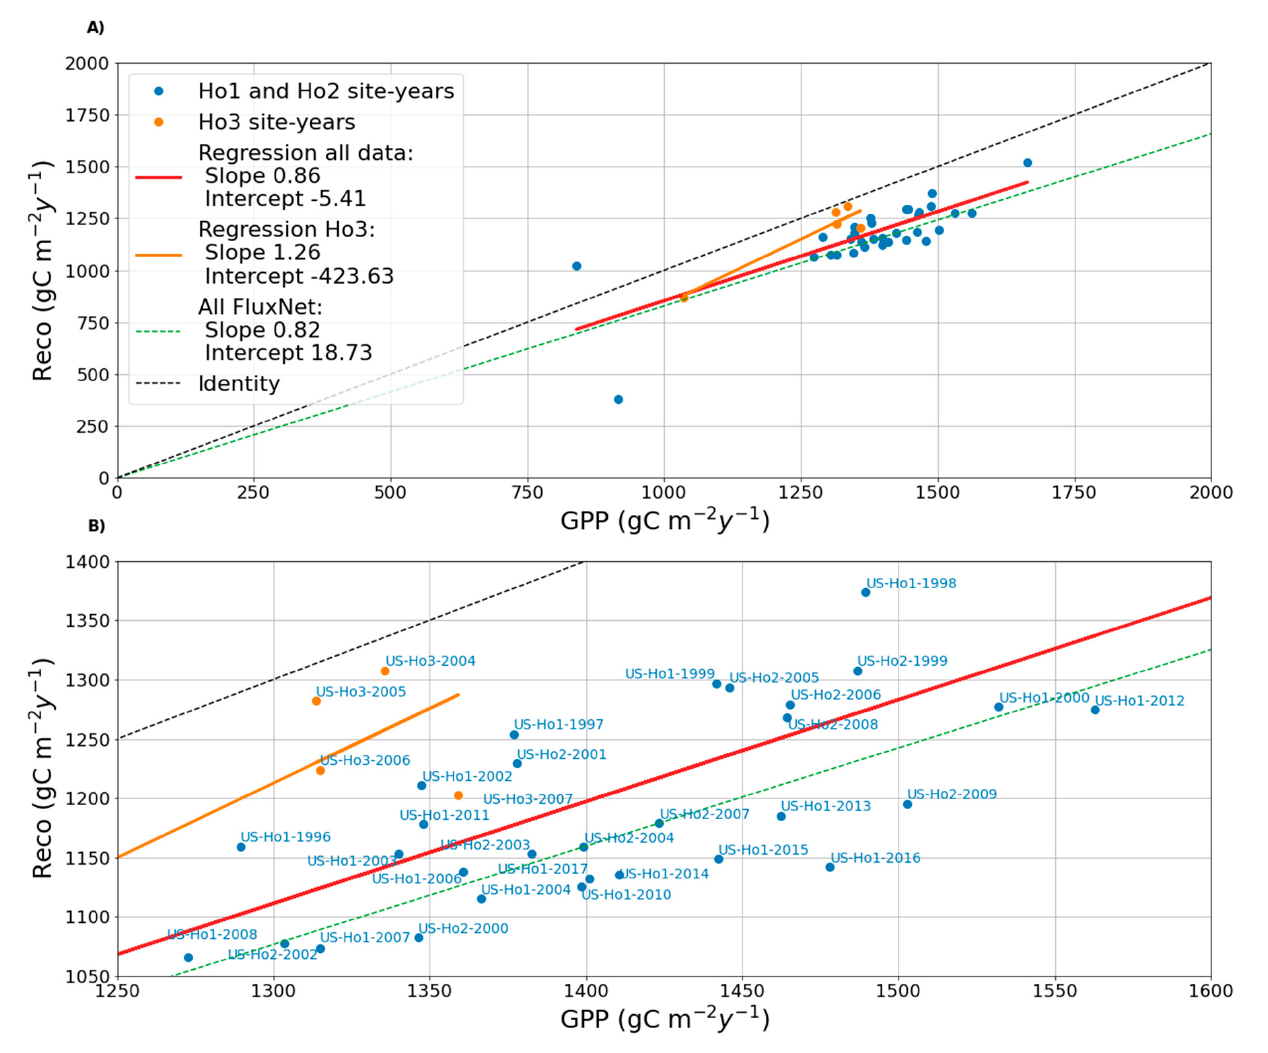
Figure 3. Yearly R eco vs. gross primary productivity (GPP) for US-Ho1, US-Ho2 (blue points) and US-Ho3 (orange points). The regression lines (using all the data, solid red line; using only US-Ho3 data, solid orange line). The identity (dashed black line) and FLUXNET regression (dashed green line) were added as a reference. ( A ) All the years; ( B ) only years in the ranges (1050; 1400) and (1250; 1600) gC m − 2 y − 1 for R eco and GPP,